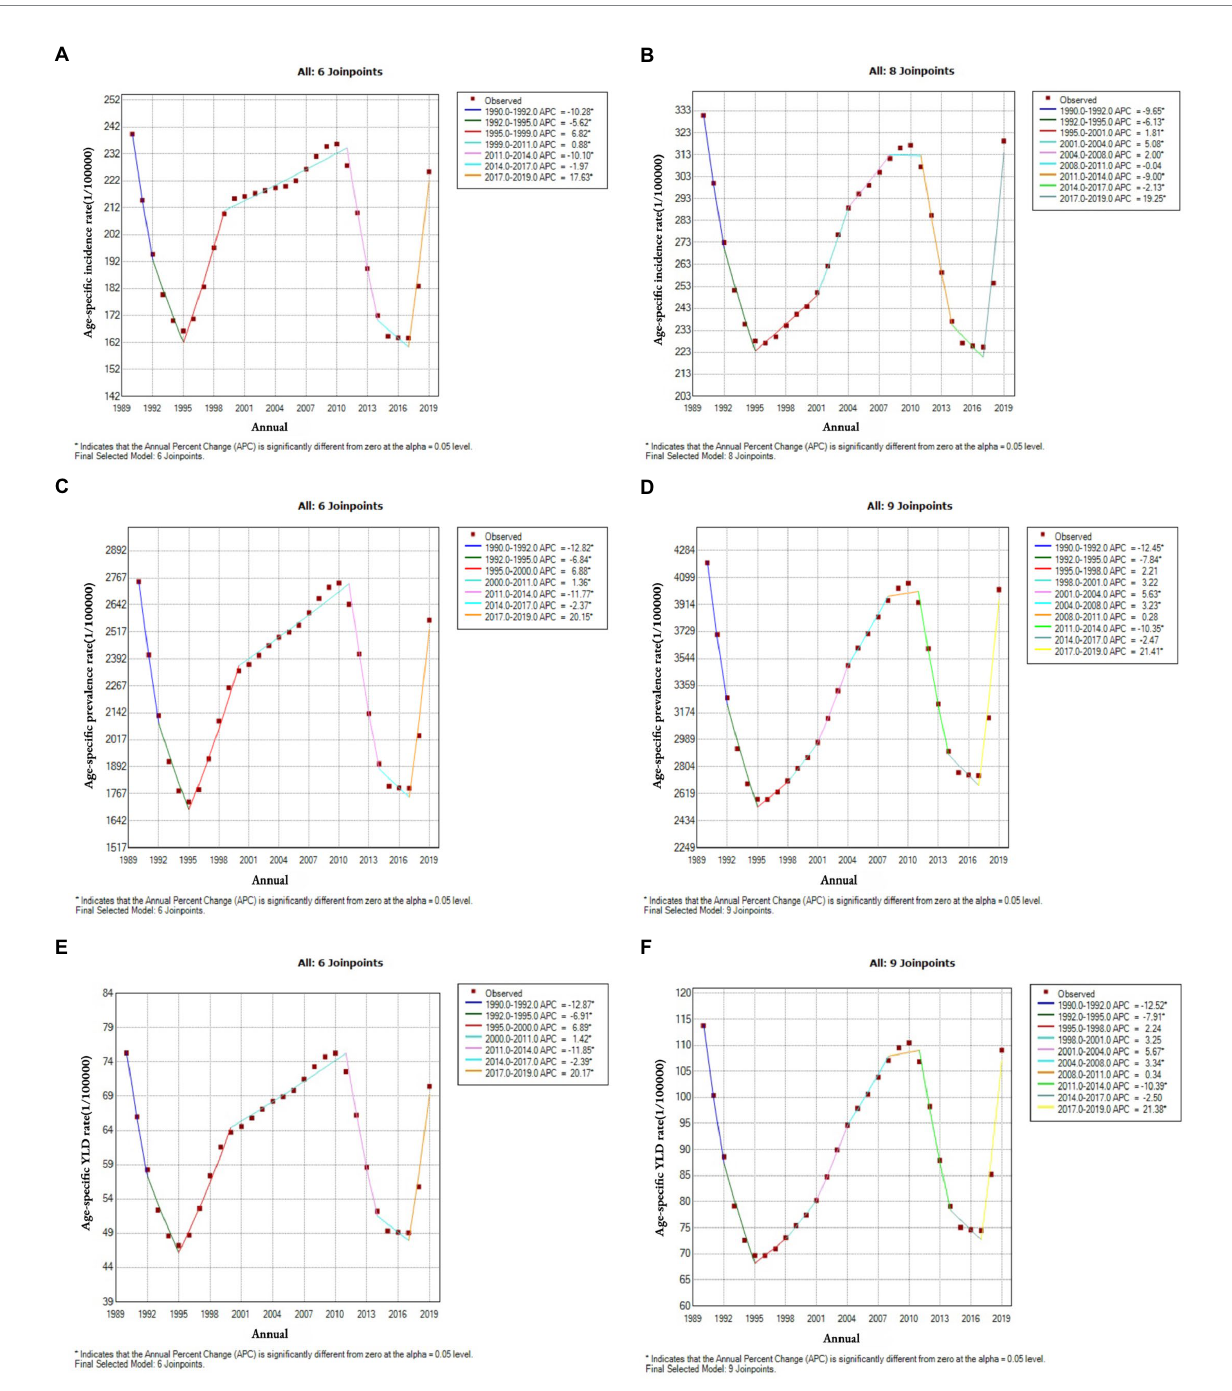
FIGURE 2 Joinpoint regression analysis of the incidence, prevalence and years lived with disability (YLDs) of edentulism in Chinese men and women (1990– 2019). (A) incidence in men, (B) incidence in women, (C) prevalence in men, (D) prevalence in women, (E) YLDs for men, (F) YLDs for